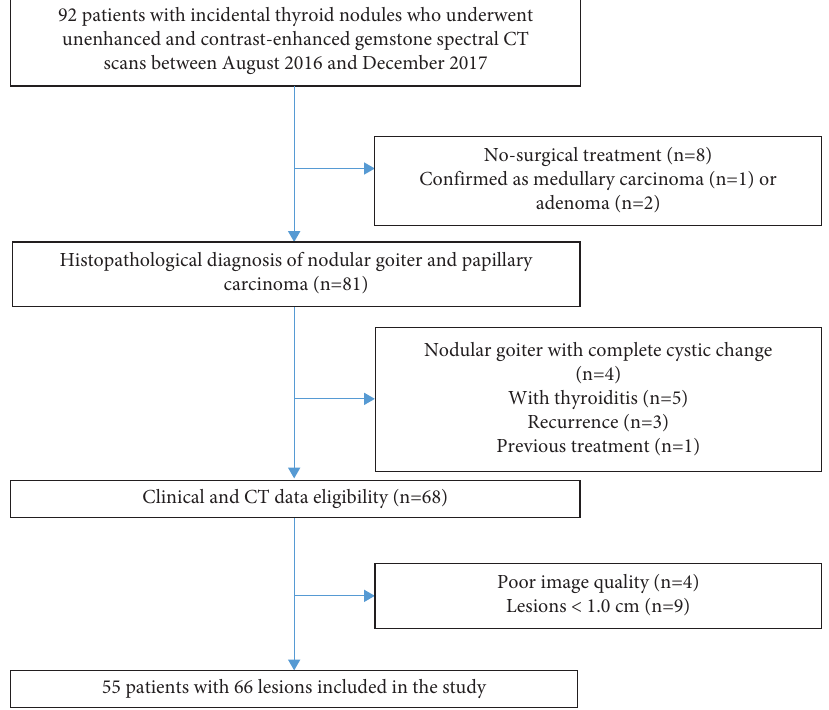
Figure 1: Study fowchart for the inclusion and exclusion of patients to obtain the fnal patient